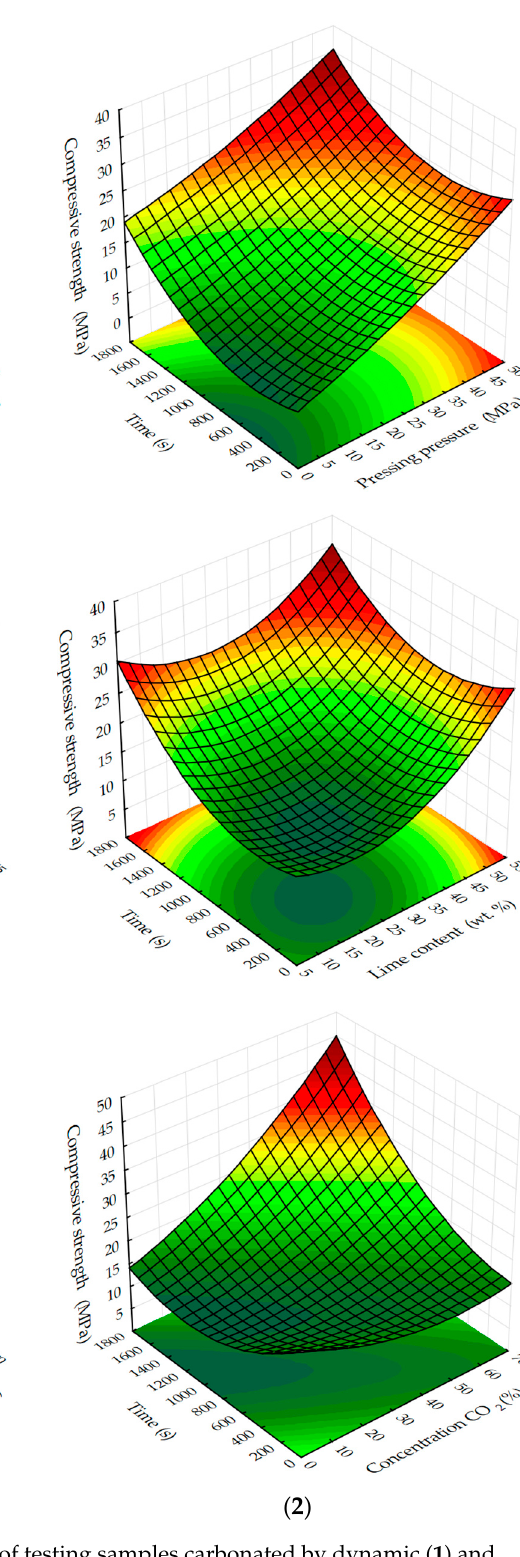
Figure 3 : Compressive strength response surfaces of testing samples carbonated by dynamic ( 1 ) and static ( 2 ) methods, depending on: ( a ) pressing pressure; ( b ) lime dust content; ( c ) CO 2 concentration (at zero level of variation of other factors).